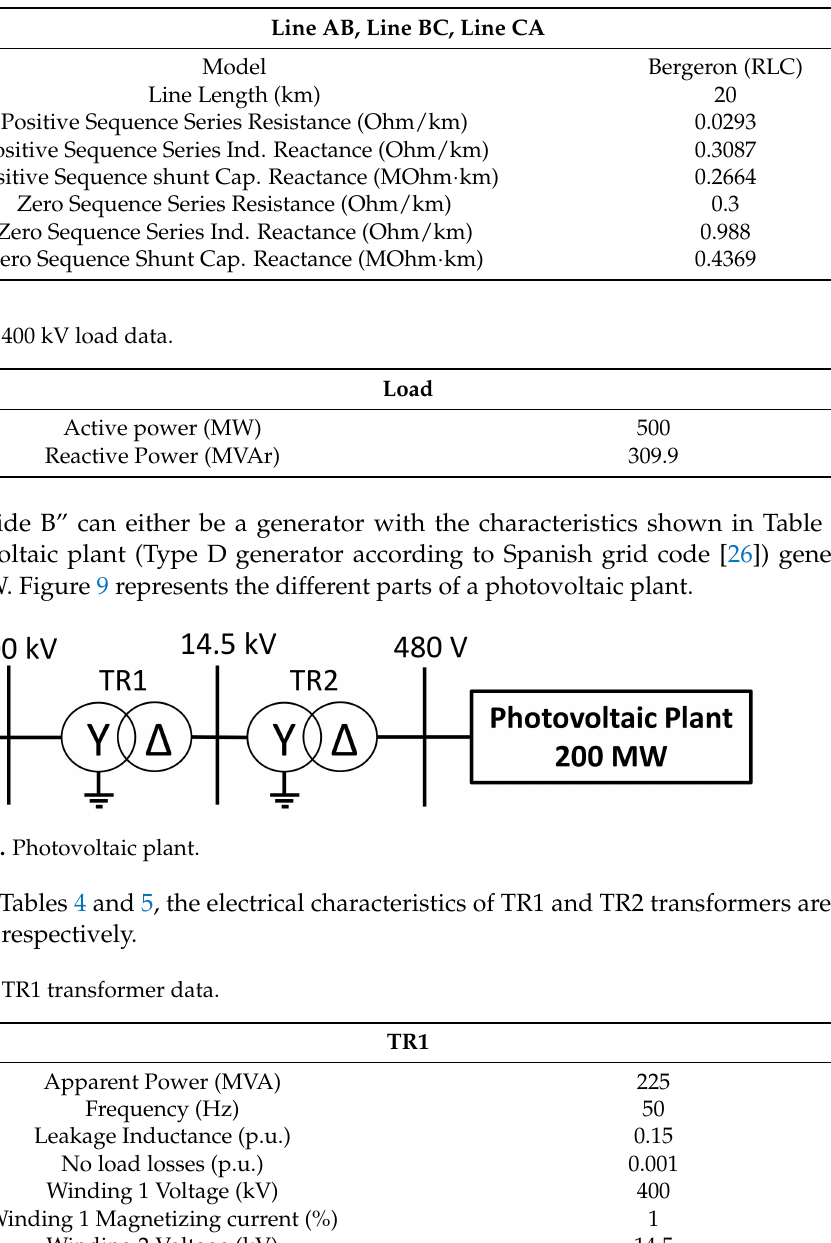
Table 2. 400 kV transmission lines data.